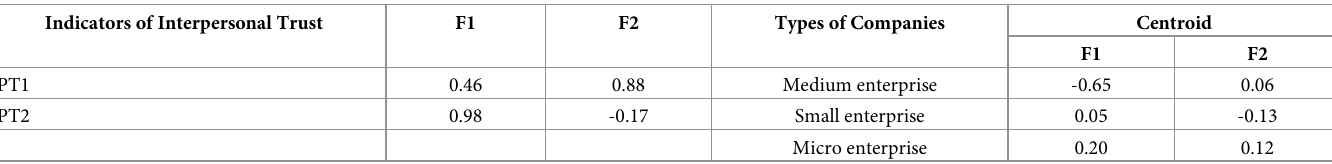
Table 10. Structure matrix and centroids’ discriminant factors of interpersonal trust.